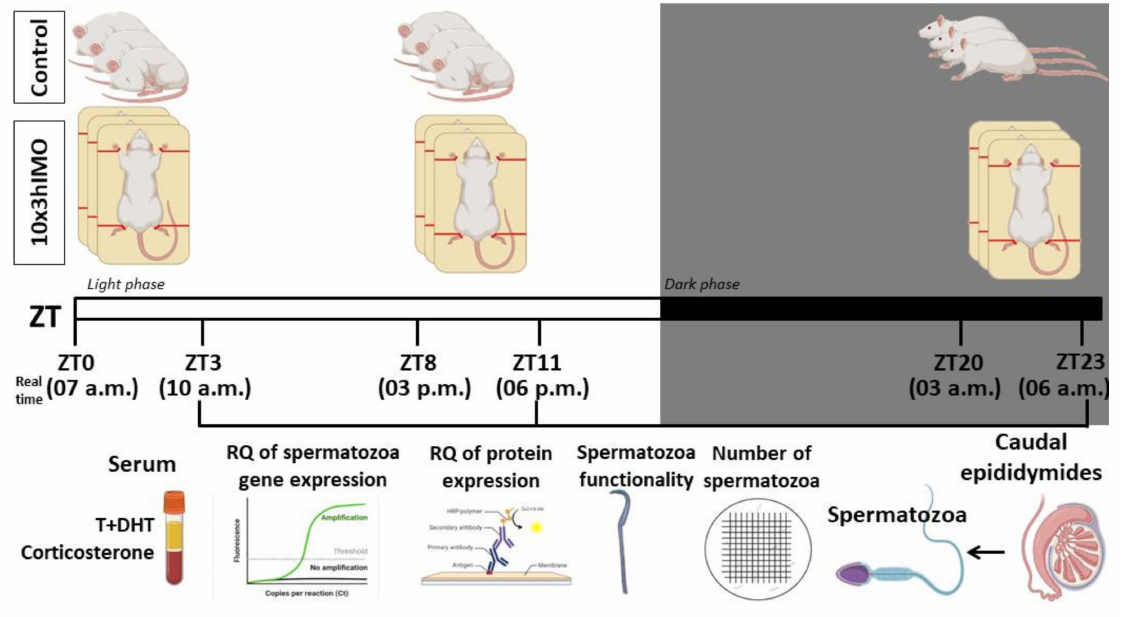
Figure 1. Experimental design of the in vivo experiment mimicking repeated stress applied at different time points during the day. Three-hour immobilization (IMO) stress was applied for 10 consecutive days (10 × 3hIMO) at different time points during the day (from ZT0 to ZT3, from ZT8 to ZT11, and from ZT20 to ZT23; ZT0 is the time when the light turned on). The relations of real time points with the ZT-time points: ZT3—3 h of stress started at 7 a.m. (ZT0; light on) and finished at 10 a.m.; ZT11—3 h of stress started at 3 p.m. (ZT8) and finished at 6 p.m.; ZT23—3 h of stress started next day at 3 a.m. (ZT20) and finished at 6 p.m. The levels of hormones, spermatozoa number and functionality (% acrosome reaction), as well as mitochondrial dynamics markers and related signaling molecules expressional profiles were followed. ZT—zeitgeber (time